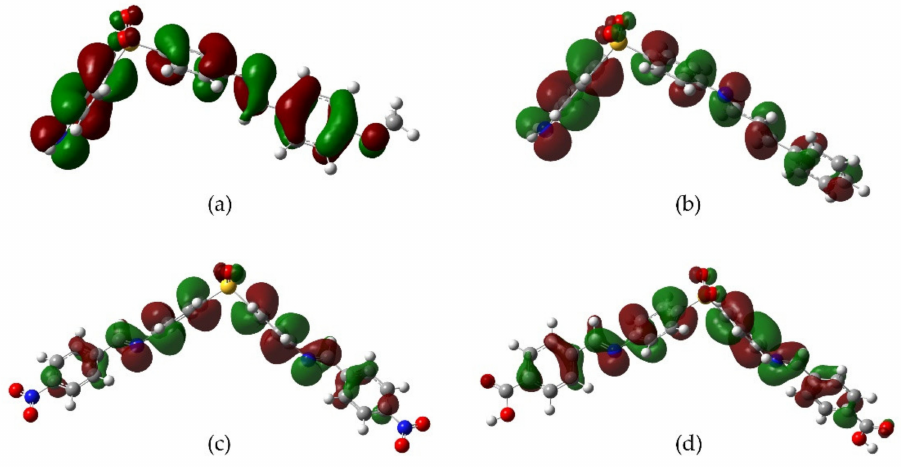
Figure 4. HOMO distribution for the most active derivatives ( a ) methoxy 3 , ( b ) cinnamoyl 10 , ( c ) nitro 4 , and ( d ) carboxyl 9